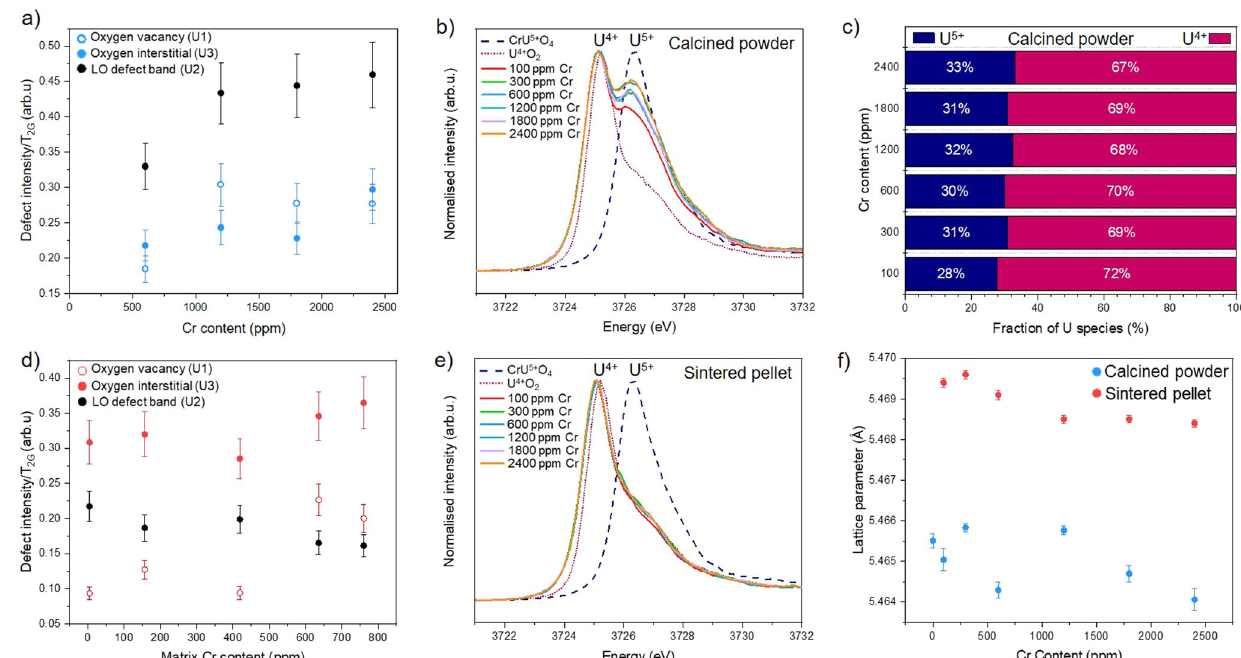
Fig. 3 Raman Spectroscopy, U M 4 -edge HERFD XANES and p-XRD analysis of Cr-doped UO 2 materials. a Oxygen defect content realised by deconvolution of Raman spectra of calcined material (errors derived from the standard deviation of 10 measurements); b U M 4 -edge HERFD XANES of calcined material. c Quanti fi cation of the U 4 + /5 + ratio in calcined powder determined from fi tting of U M 4 -edge HERFD XANES data in b. d Oxygen defect content of sintered material realised by deconvolution of Raman spectra (errors derived from the standard deviation of 10 measurements). e U M 4 -edge HERFD XANES of sintered material; and ( f ) lattice parameter values for calcined powder and sintered material, as determined by p-XRD (errors derived from the lattice parameter re fi